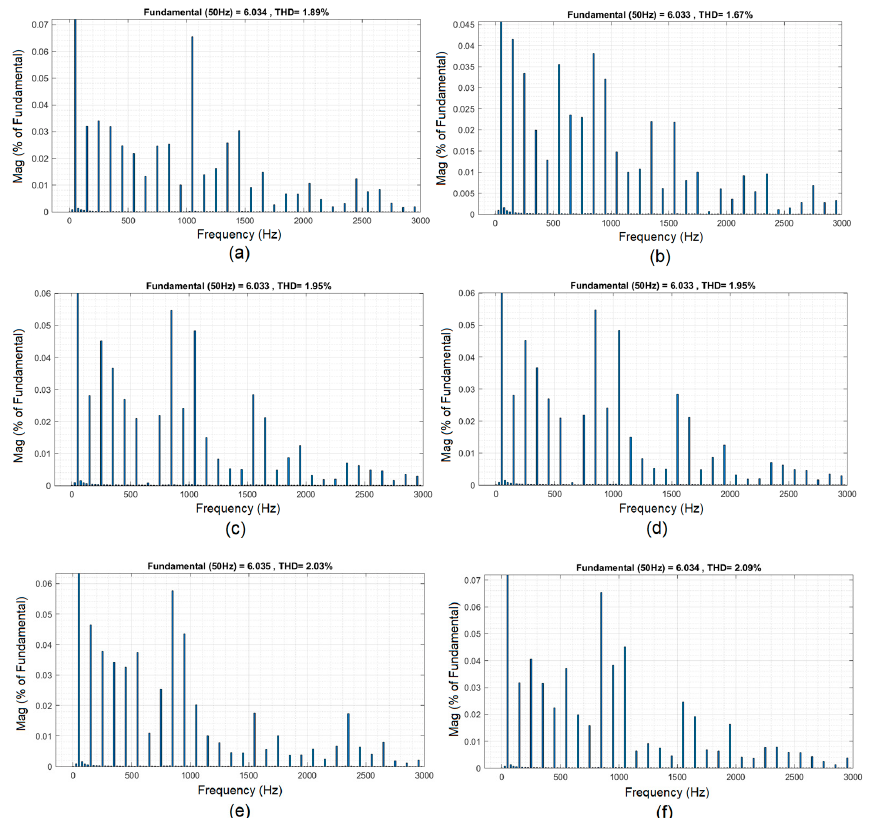
Figure 6. FFT analysis of the output current of the 19-level MLI at a modulation index of 0.8 for ( a ) BMO; ( b ) GA; ( c ) GWO; ( d ) MFO; ( e ) SPBO; and ( f ) SPSA.